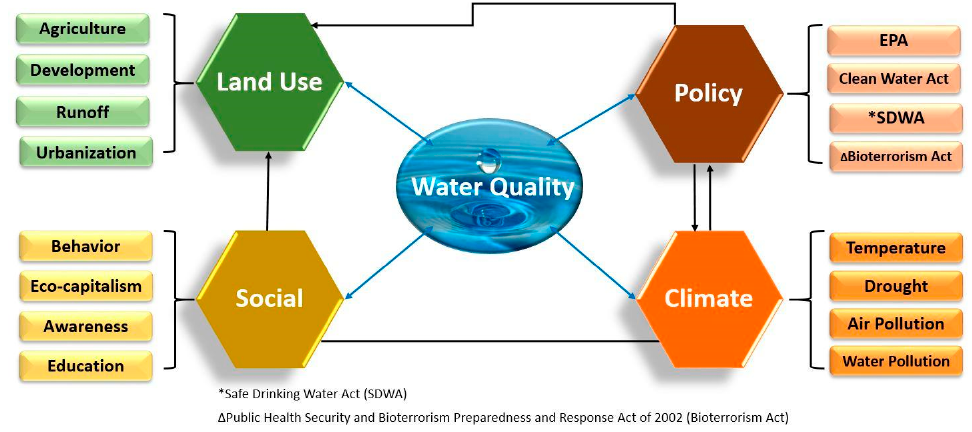
Figure 3. Dimensions of water quality as identified in the Socio-Environmental Synthesis framework.